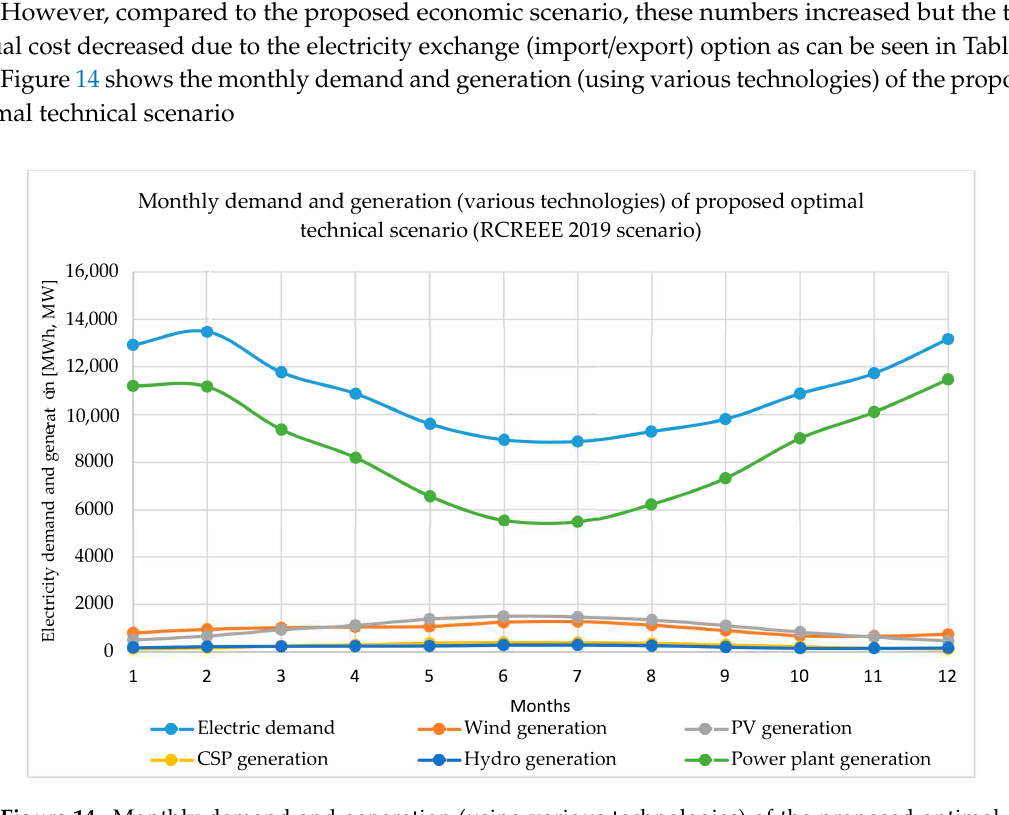
Figure 14. Monthly demand and generation (using various technologies) of the proposed optimal technical scenario (RCREEE 2019